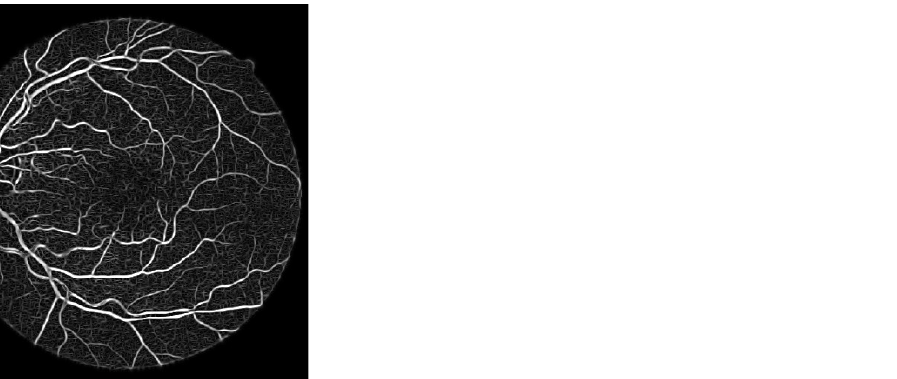
Figure 10. Second-order Gaussian derivative detectors output Image: Initial Coherent Vessels Image.